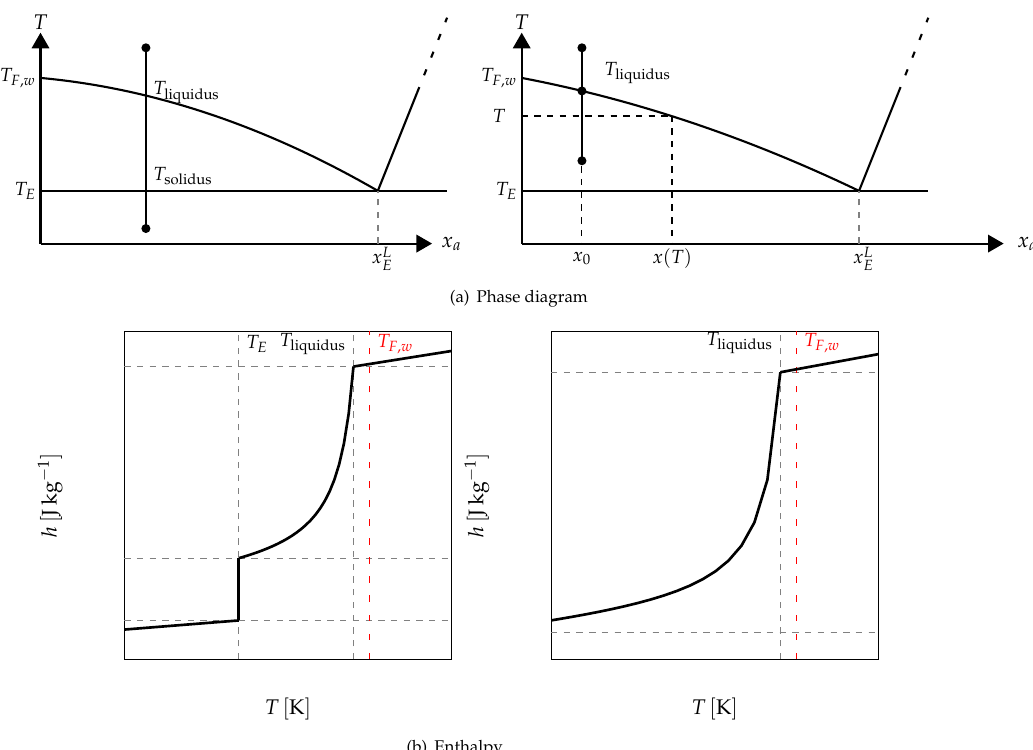
Figure 16: Phase diagram of an aqueous solution with an eutectic equilibrium and the specific enthalpy with (left) and without (right) the eutectic melting .